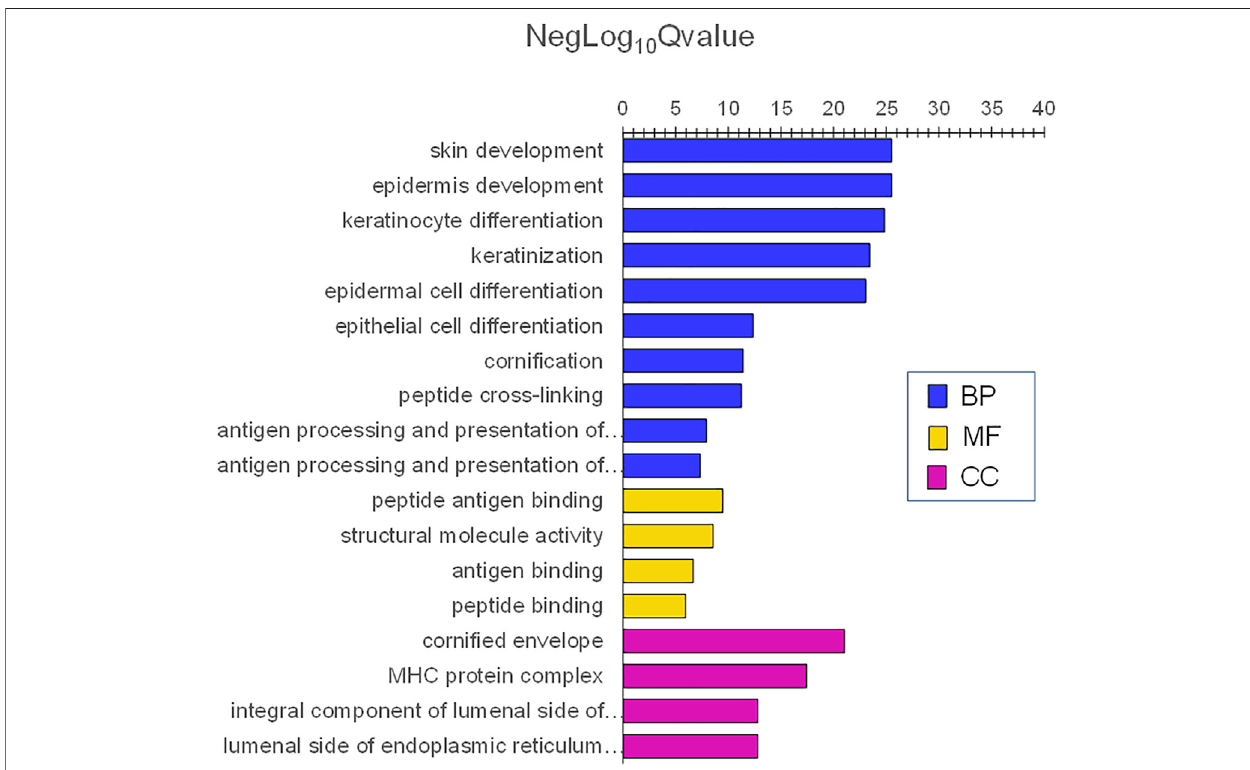
FIGURE 9 | Gene ontology themes with enriched gene expression in adult skin. Signi fi cantly expressed genes were analyzed for enrichment of biologic themes (GeneOntology)usingtheclusterPro fi lerpackage(Yuetal.,2012),EnrichmentMap(Mericoetal.,2010),andg:pro fi ler(Raudvereetal.,2019).Signi fi cantpathwayswere selected using the false discovery rate (FDR)adjusted p values. NegLog 10 Qvalue indicates -Log 10 FDR adjusted p value. The lowest adjusted p values for BP were skin development, epidermis development, keratinocyte differentiation, keratinization, and corni fi cation. Immune BPs included antigen processing and presentation of exogenousantigen,majorhistocompatibilityproteincomplex,andantigen-bindingwerealsoprominent.Highlysigni fi cantMFwaspeptideantigenbindingandstructural molecule activity and CC was a corni fi ed envelope and major histocompatibility complex (MHC) protein